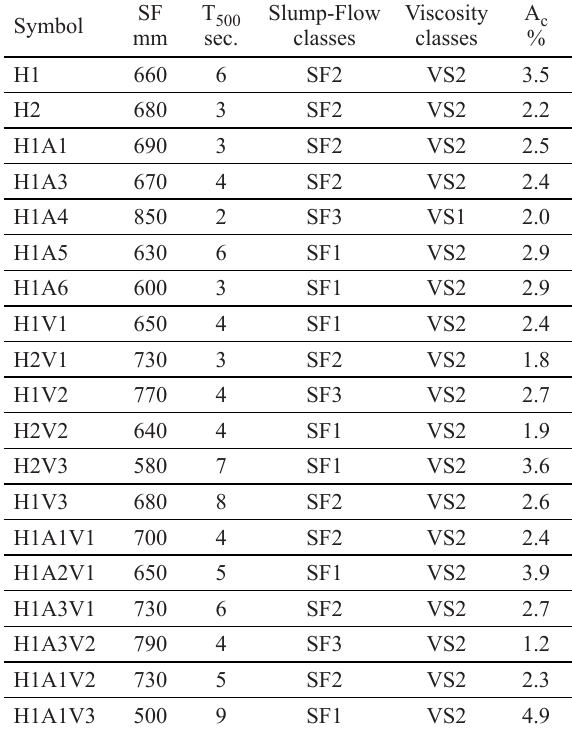
Table 10. Properties of fresh HPSCC (Łaźniewska-Piekarczyk 2013) Symbol